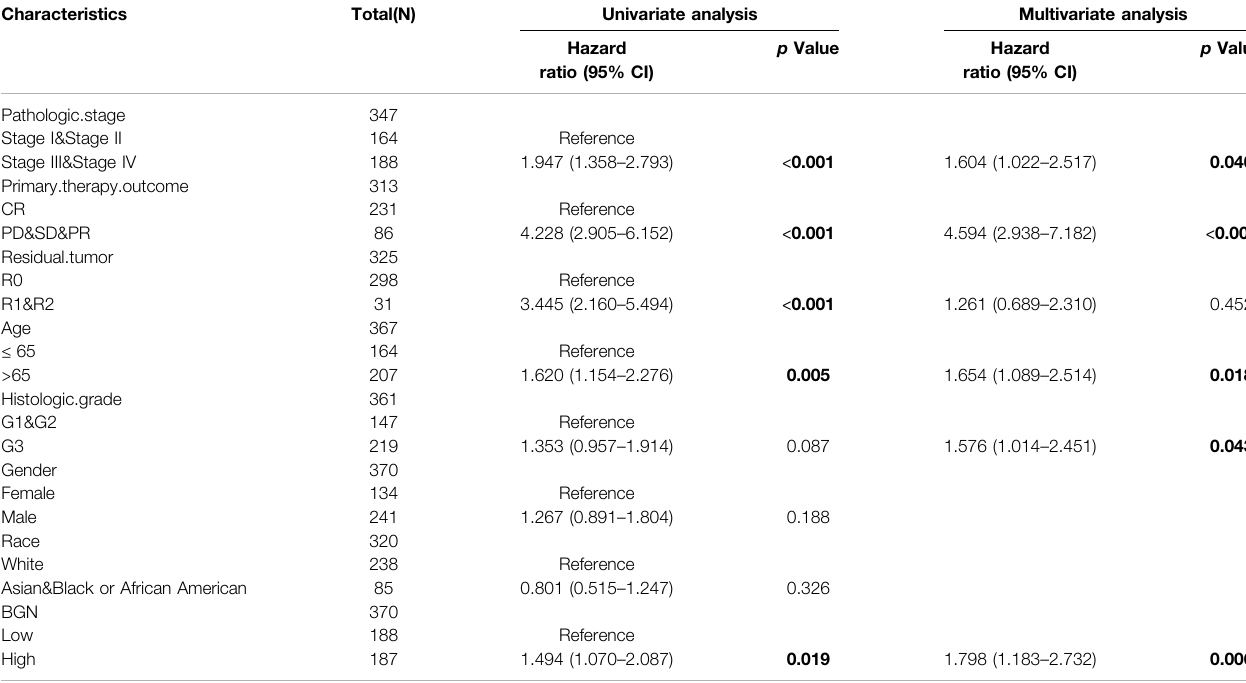
R0,Novisibleormicroscopictumorresidue;R1,Novisible,butmicroscopicresidualtumor;R2,Visibletumorresidue;CR,Completeresponse;PR,Partialresponse;SD,Stabledisease; PD, Progressive disease. Bold indicates statistically signi fi cant, that is, a p value less than